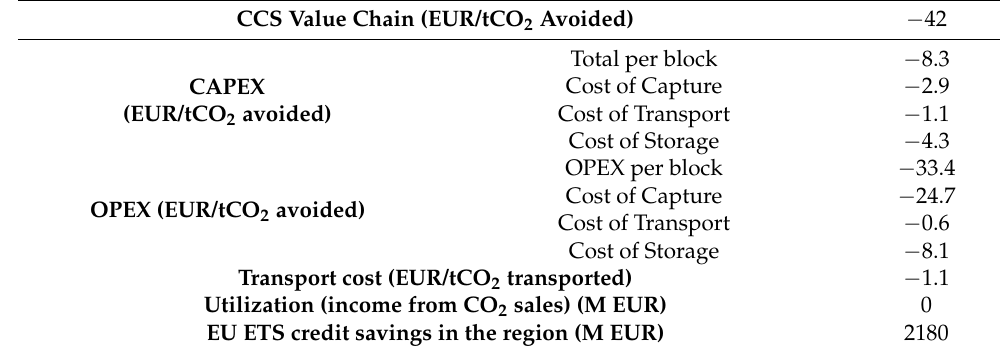
Table 6. Analysis of CCUS system in terms of EUR/tCO 2 avoided using the EU ETS parameters of Table